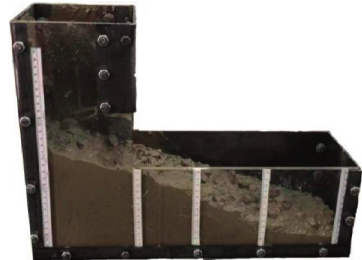
Figure 5: L-box experiment.